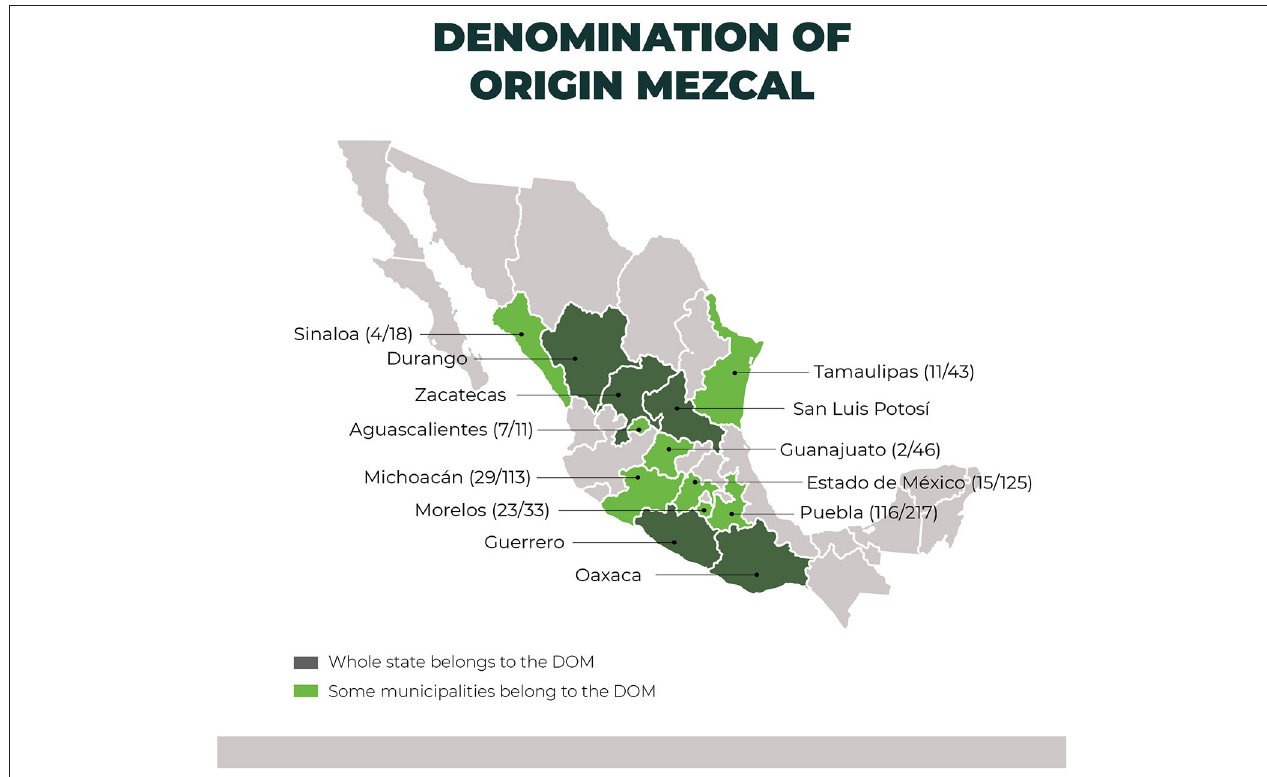
TABLE 1 | Allowed process configurations of the different mezcal categories (NOM). Categories Mezcal Artisanal mezcal Ancestral mezcal of mescal Main